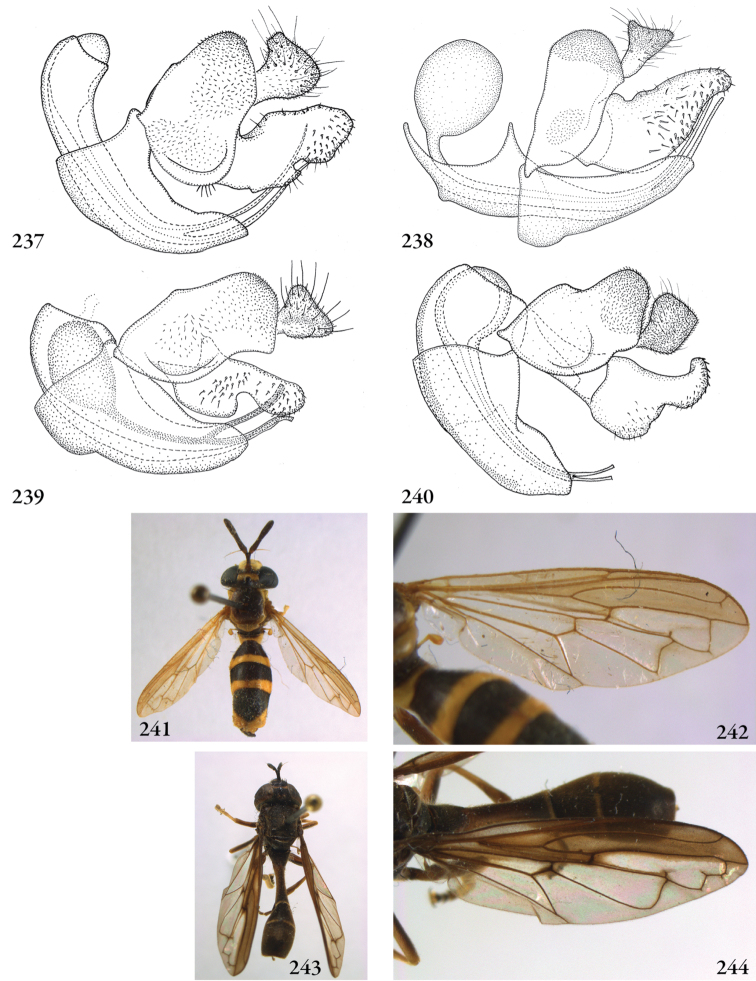
237–240
Microdon (s.l.), male genitalia: 237
Microdon carbonarius (holotype) 238
Microdon pictipennis (Australia, coll. W. van Steenis) 239
Microdon tsara (holotype) 240
Microdon waterhousei (Australia, coll. M. Hauser) 241–242
Mixogaster breviventris male (USA, coll. RMNH): 241 habitus dorsal 242 wing 242–244
Mixogaster thecla male (Brazil, coll. J.T. Smit): 243 habitus dorsal 244 wing.